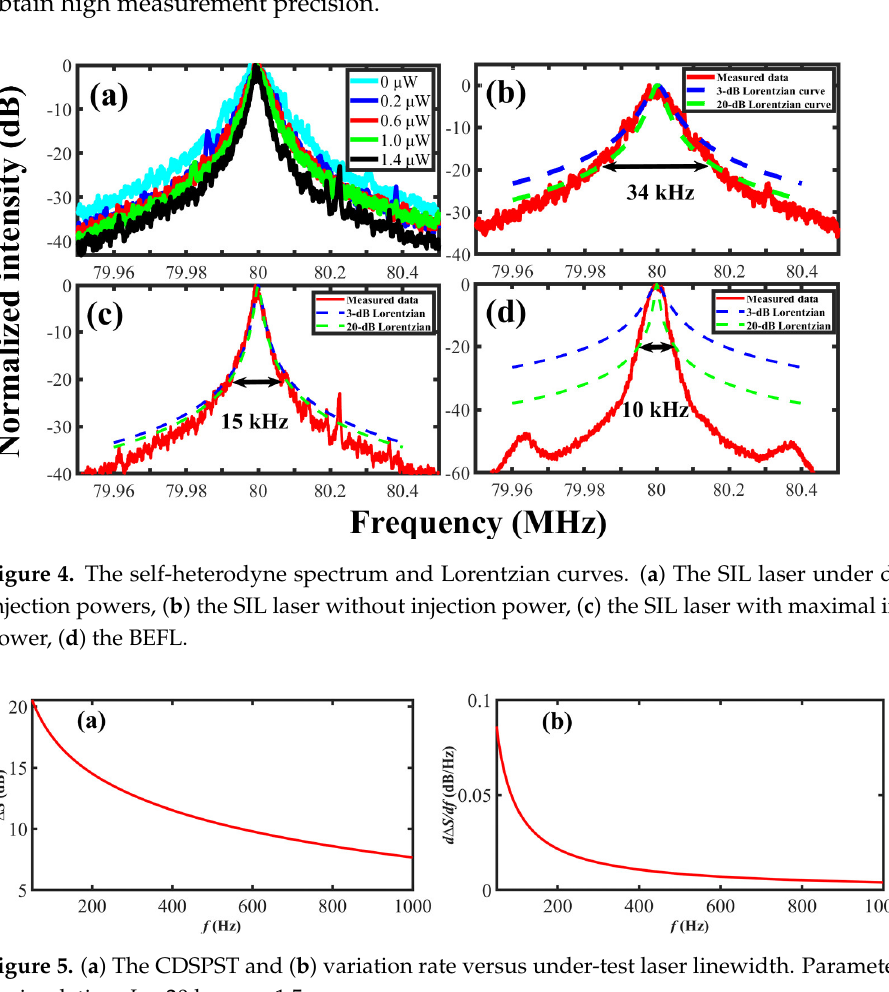
Figure 4. The self-heterodyne spectrum and Lorentzian curves. ( a ) The SIL laser under different injection powers, ( b ) the SIL laser without injection power, ( c ) the SIL laser with maximal injection power, ( d ) the BEFL.